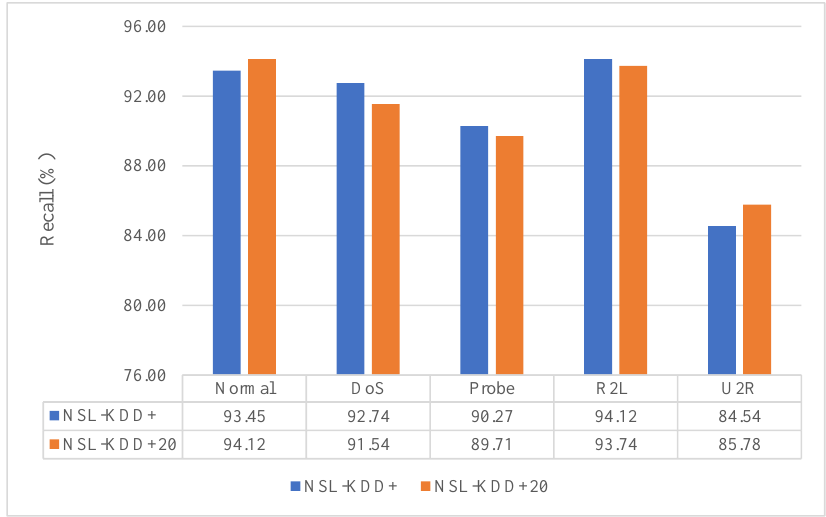
Figure 4. Recall rate of different classes on NSL-KDD+ and NSL-KDD+20 datasets.